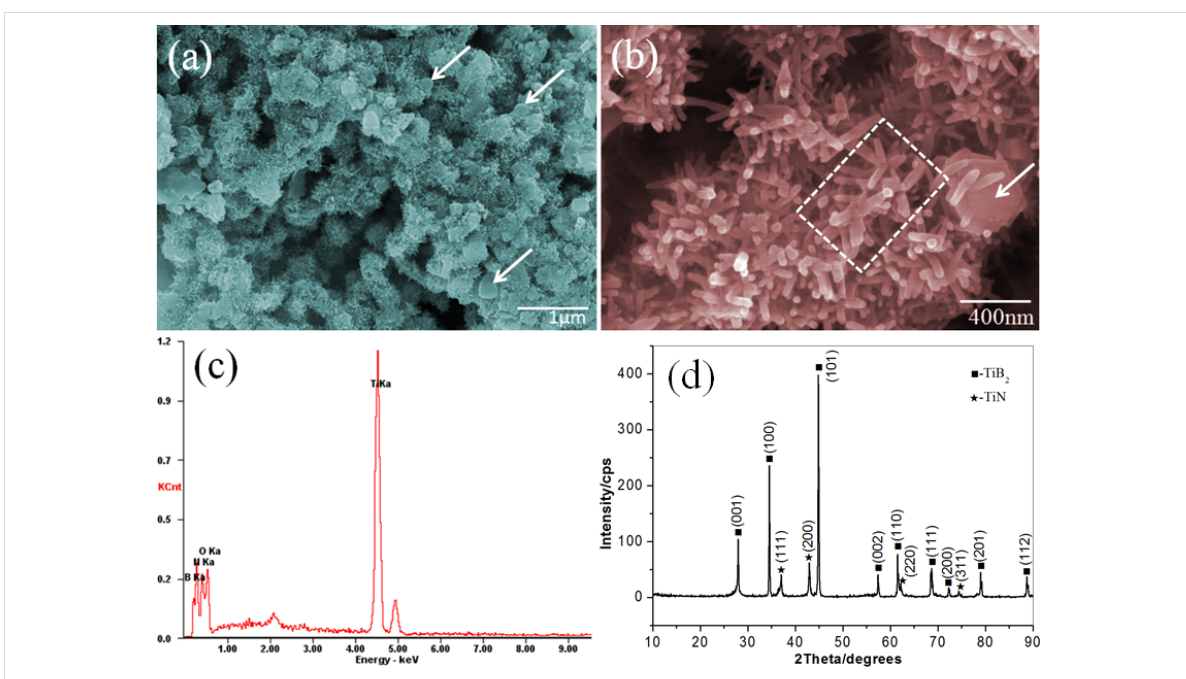
Figure 1: Typical field emission scanning electron microscope (FSEM) images (a, b), EDX spectra (c) and XRD pattern (d) of the as-synthesized TiB 2 /(TiB 2 –TiN) samples. Scale bars: (a) 1 μ m and (b) 400 nm.